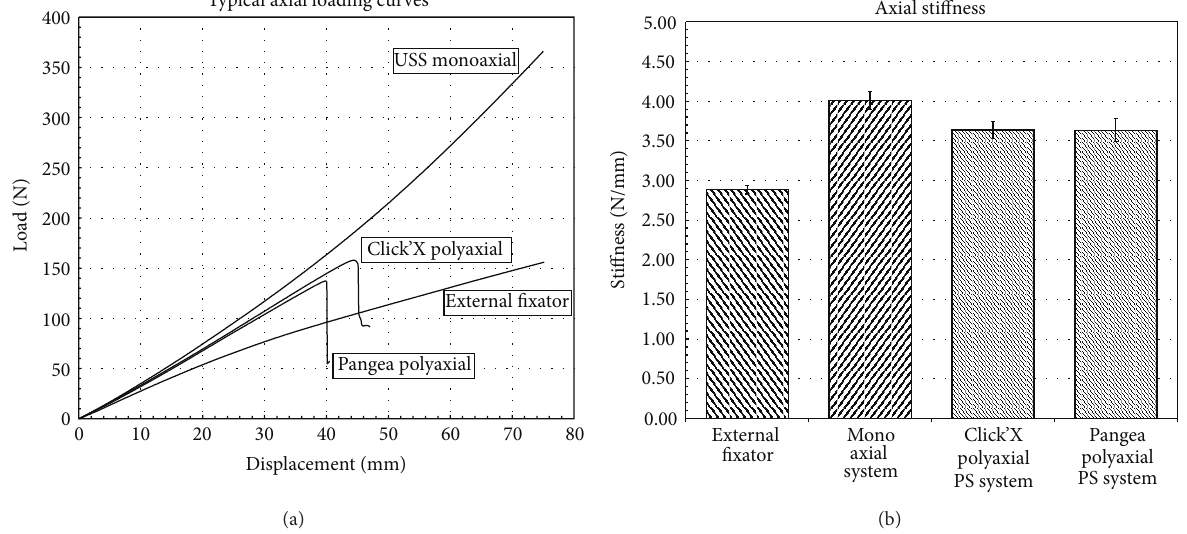
Figure 4: (a) Load displacement curves for axial testing which show that the polyaxial systems failed after 40 mm of displacement. (b) The polyaxial screws were slightly less stiff than the monoaxial system and all three-screw systems were stiffer than the external